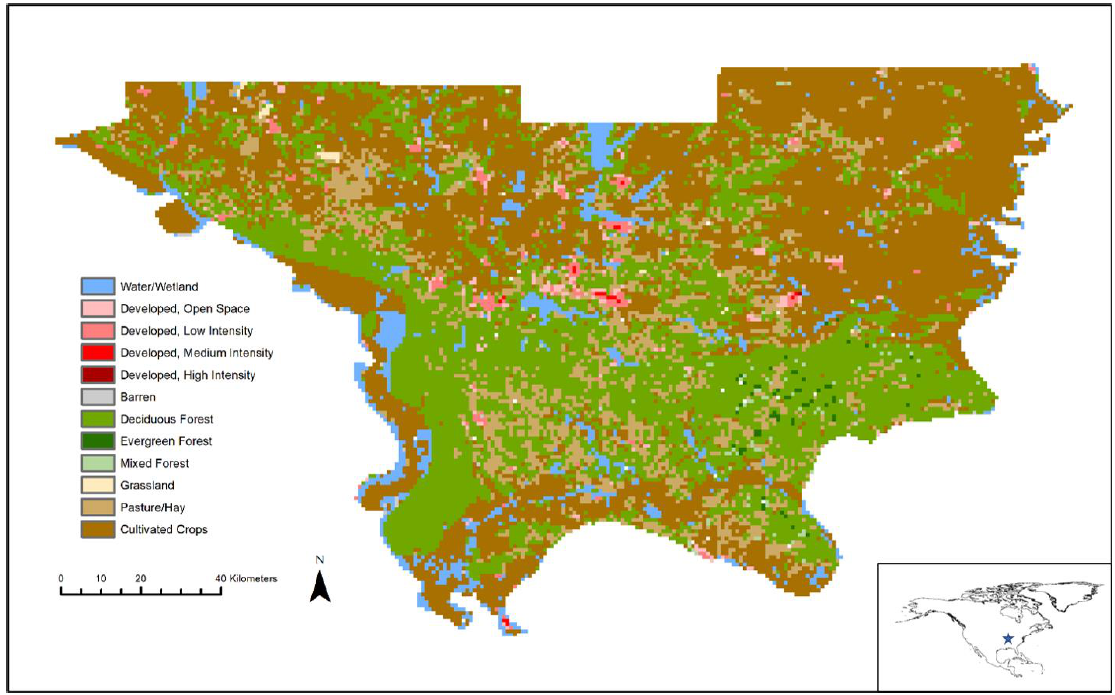
Figure 2. Land cover classes of southern Illinois, USA [15]. Classes were resampled to 1 km 2 and open water, wooded wetlands, and emergent herbaceous wetlands were combined to one class.